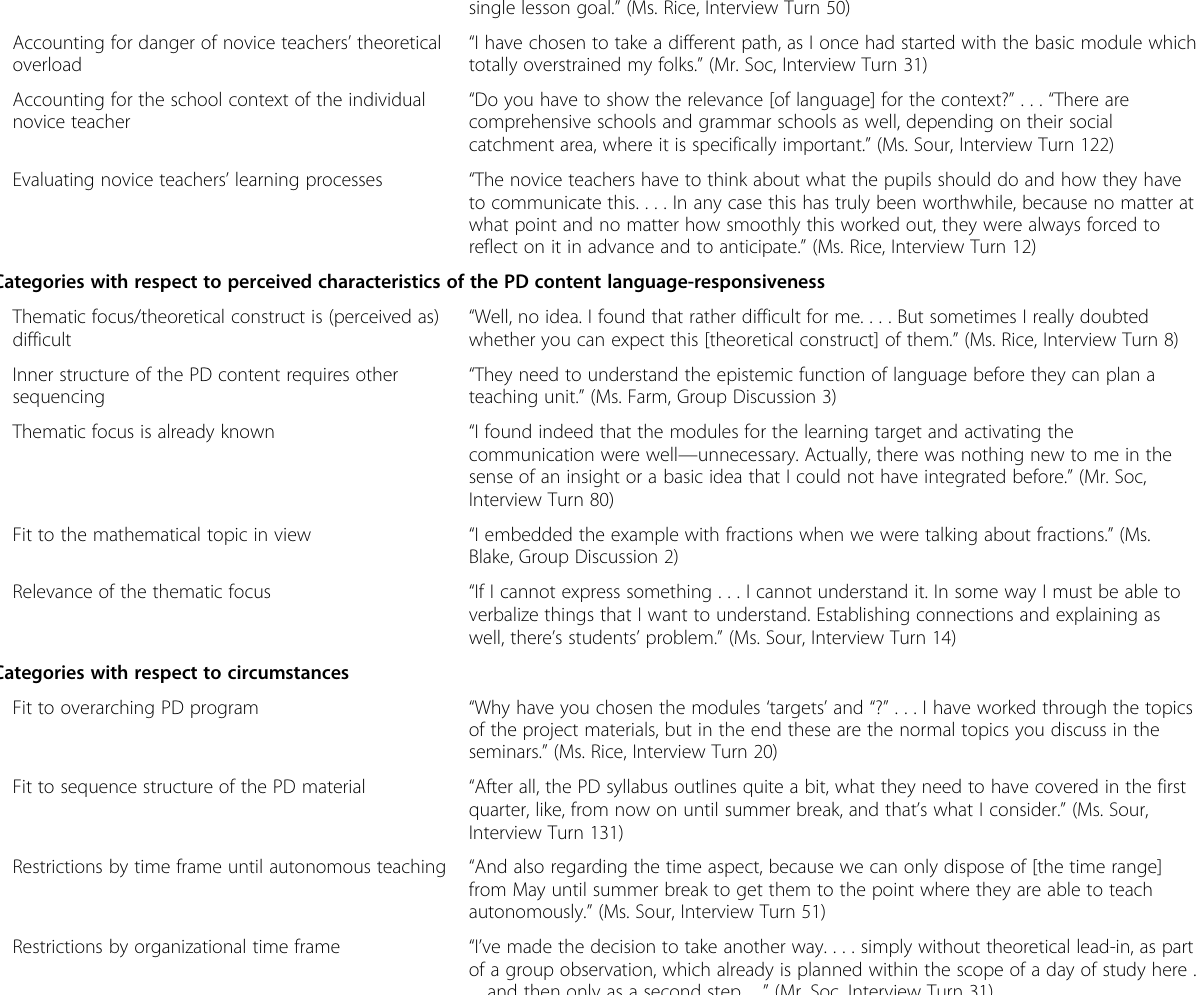
Table 1 Individual categories underlying the facilitators ’ materialized adaptation actions Individual category Example from the transcripts (translated from German) Categories with respect to teachers as learners Accounting for novice teachers ’ learning starting